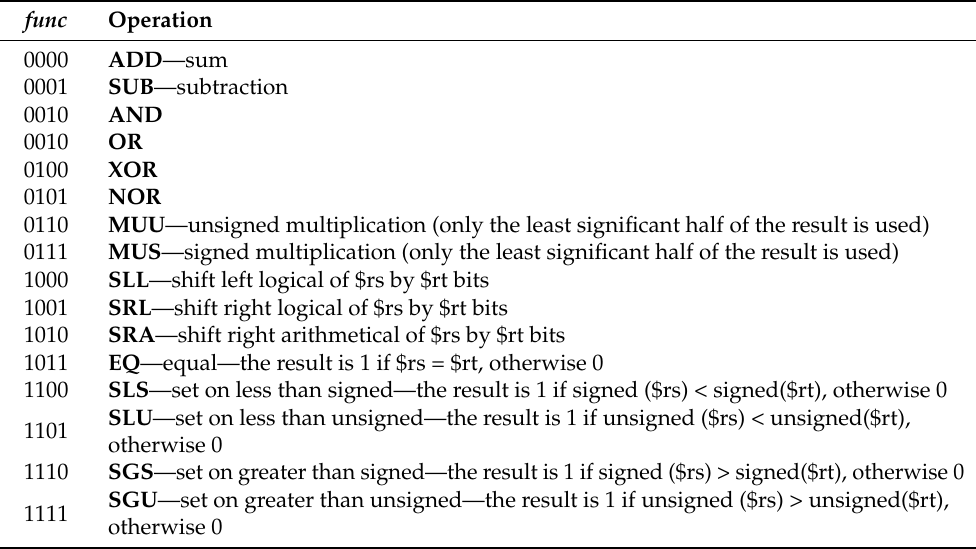
Table 2. Operations supported by the